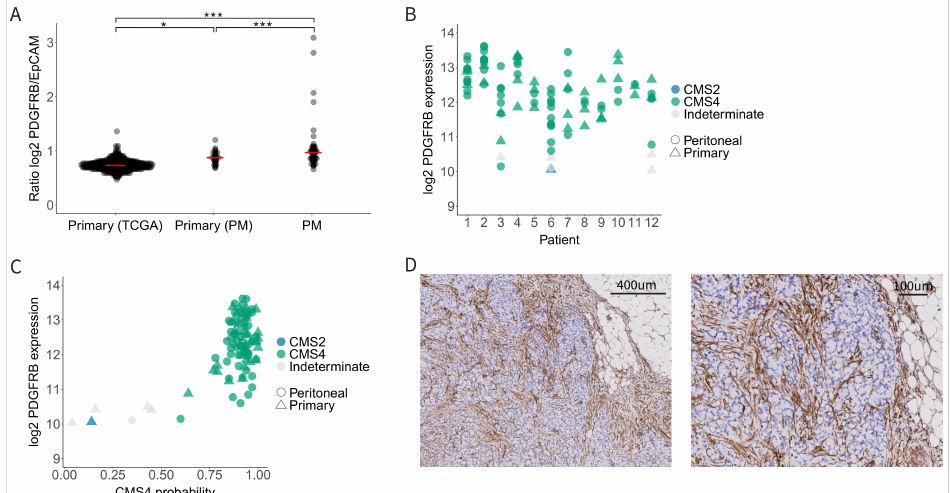
Figure 2. PDGFRB expression in CMS4 peritoneal metastases. ( A ) Relative PDGFRB expression levels in the TCGA cohort (primary CRC tumours, n = 592) versus the peritoneal metastasis cohort (primary tumours with peritoneal dissemination, n = 35, and the peritoneal metastases derived from them, n = 59). Each dot represents a tumour sample, the red bar represents the median PDGFRB/EpCAM ratio. ( B ) Dot plot showing PDGFRB expression levels in primary tumours and their matched peritoneal metastases. Tissue type (primary vs. PM) is annotated by shape and CMS classification is color-coded. ( C ) Scatter plot showing the correlation of CMS4 probability with PDGFRB mRNA levels in the peritoneal metastasis cohort. PDGFRB mRNA levels correlate very well with CMS4 probability of the same lesions. ( D ) Immunohistochemistry for PDGFRB on peritoneal metastasis tissue from the same peritoneal metastasis cohort. The tumour stroma of 17/18 peritoneal metastasis was positive for PDGFRB. Significance levels * p < 0.05, *** p <